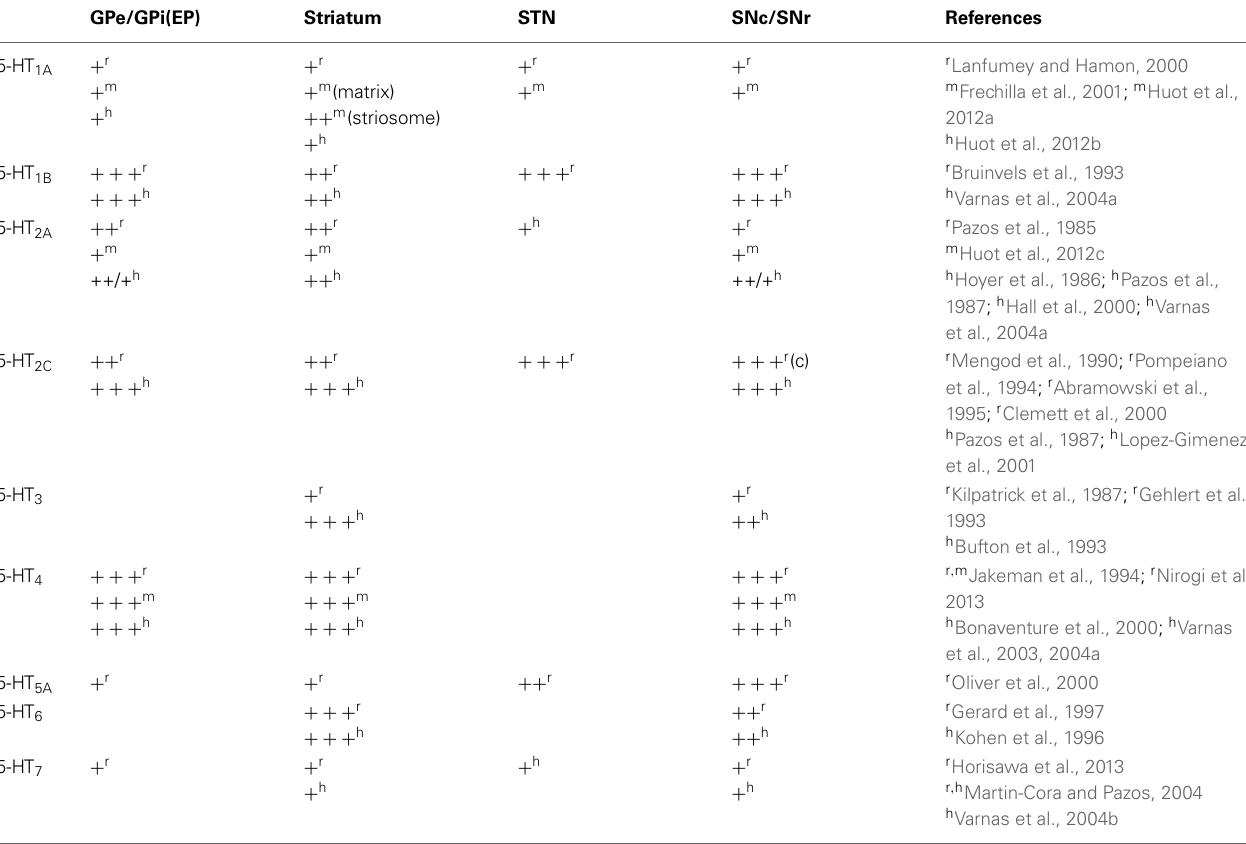
Table 1 | Localization and expression density of serotonergic receptors in the basal ganglia of healthy brains of rodents, monkeys and